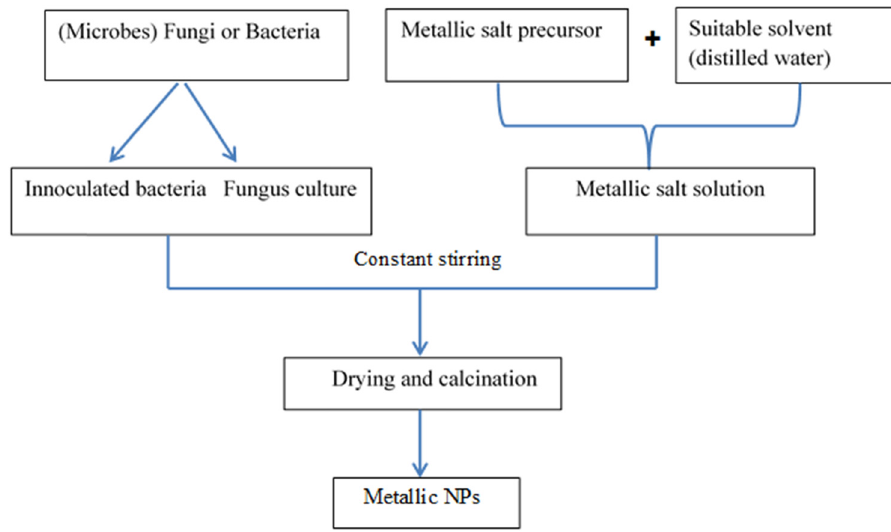
Figure 3: Pictorial representation of microbe - mediated NP synthesis.